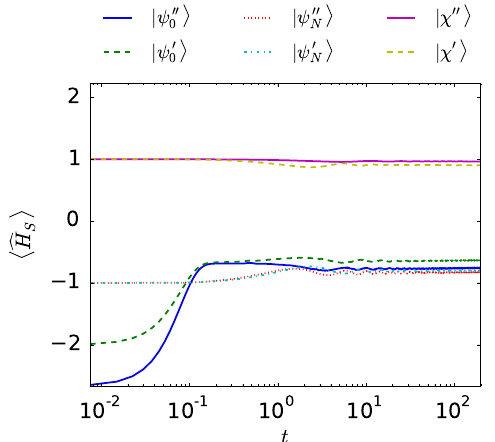
Figure 10: Energy of the CS (in units of J ) for a Hamiltonian that contains an anisotropy S = H + H (cid:48) = H + H (cid:48)(cid:48) or (cid:210) H . The primes on the initial states in the legend refer to the (cid:210) H S S S S S S Hamiltonian with the respective anisotropy. The environment consists of N (cid:69) = 16 particles with coupling strength K = 0.02 J . Time t has been made dimensionless in units of J S / ħ h ≡ t i.e. t (cid:48) → t (cid:48) J S